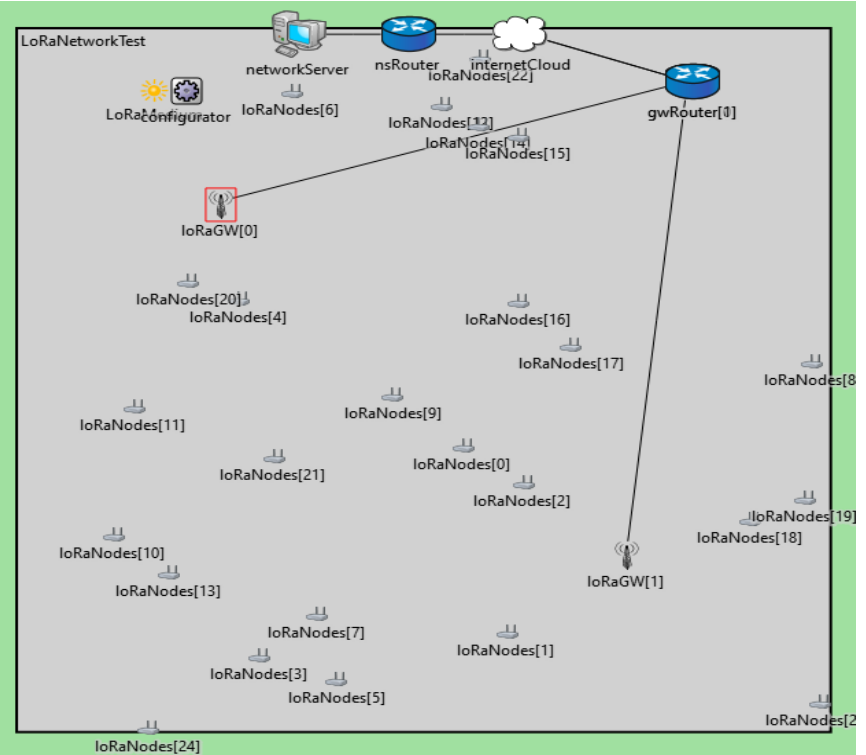
Figure 2. Small network layout and gateway distributions.